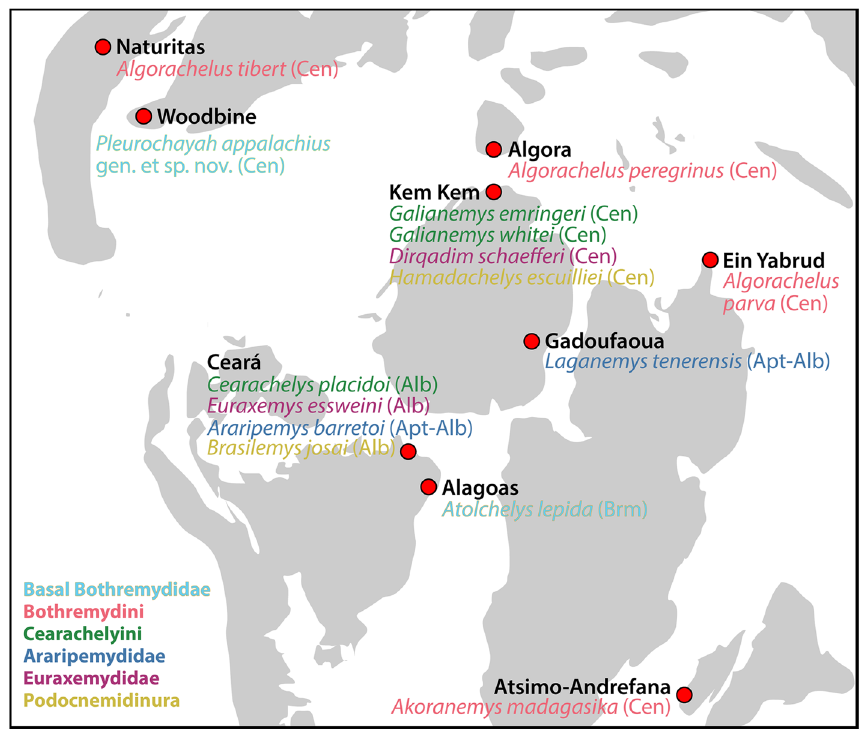
Figure 9. Geographical position of the type localities (red circles) of known fossil crown pleurodires in Laurasia and northern Gondwana during and prior to the Cenomanian (Upper Cretaceous). Modified from global Mollweide projection at 96.6 Ma by Scotese 87 . Colors of taxon text corresponds with clades at